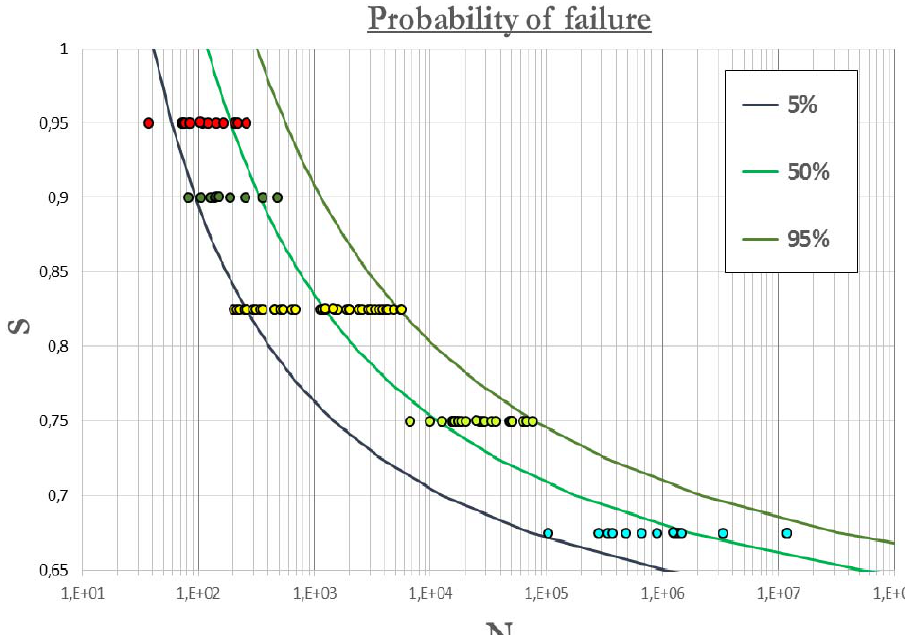
Figure 2: S-N field fitted with the Weibull model of Castillo-Canteli [6] for the normalized fatigue results for concrete under compression from Holmen [4].